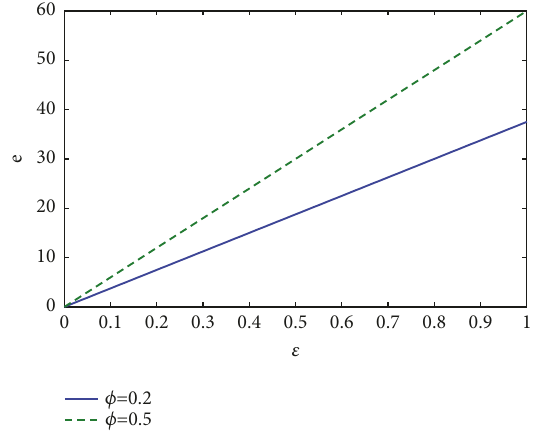
=0.2  =0.5 Figure 5: The changes of platform advertisement in two situations.